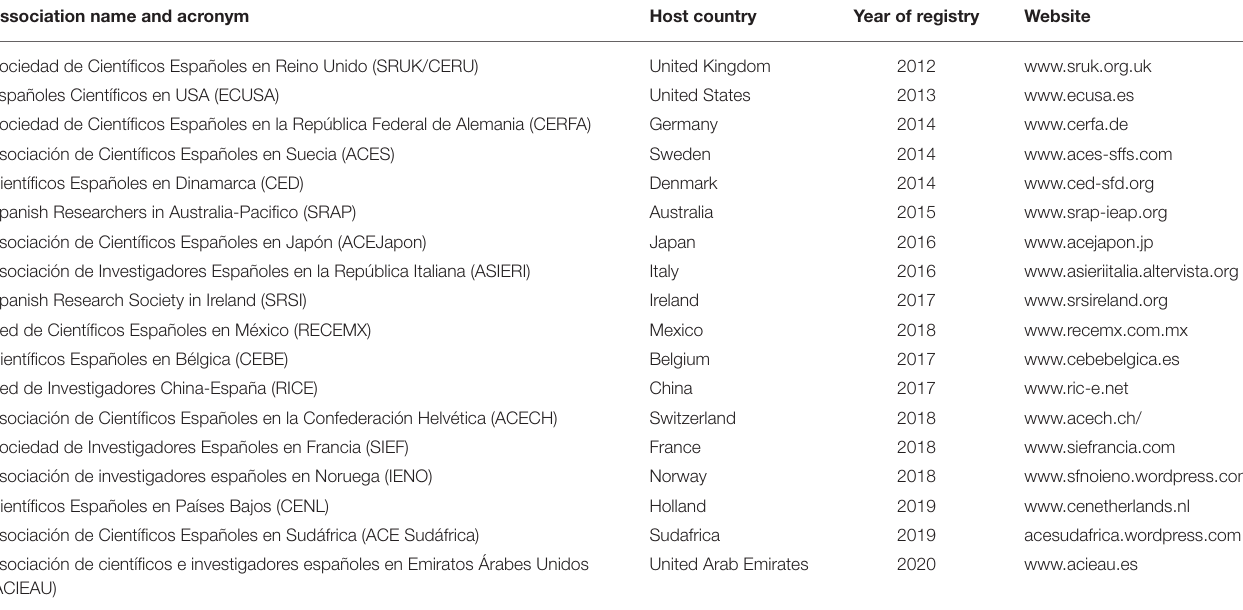
TABLE 1 | The 18 associations of Spanishs scientist and researchers abroad officially launched from 2012 to 2020. Association name and